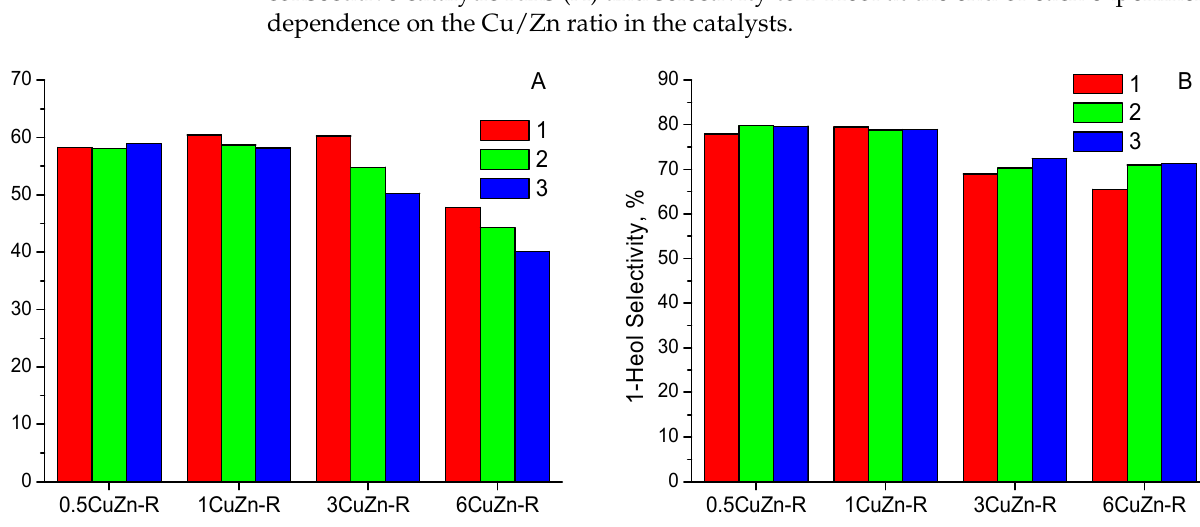
Figure 9. MeHe conversion observed after 180 min in three consecutive runs (numbers 1, 2, and 3 stand for the corresponding reaction runs) in presence of CuZn catalysts ( A ) and selectivity to 1-Heol at MeHe conversion of 40% ( B ). Catalyst weight—1.5 g, MeHe load—0.69 mol, T reac. = 210 °C, p H2 = 100 bar.